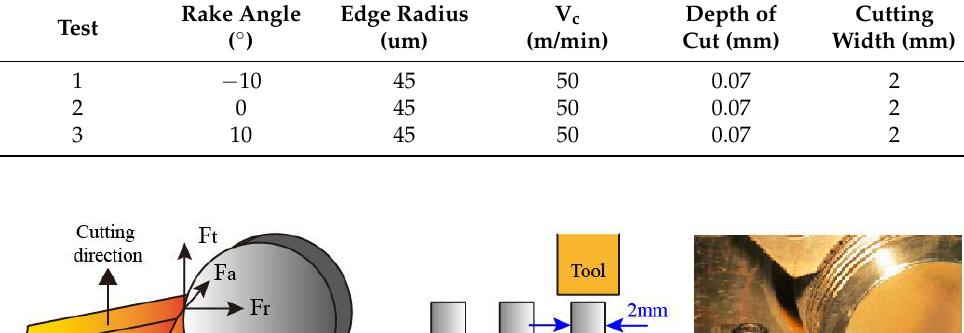
Table 3. Implemented cutting test parameters and conditions.